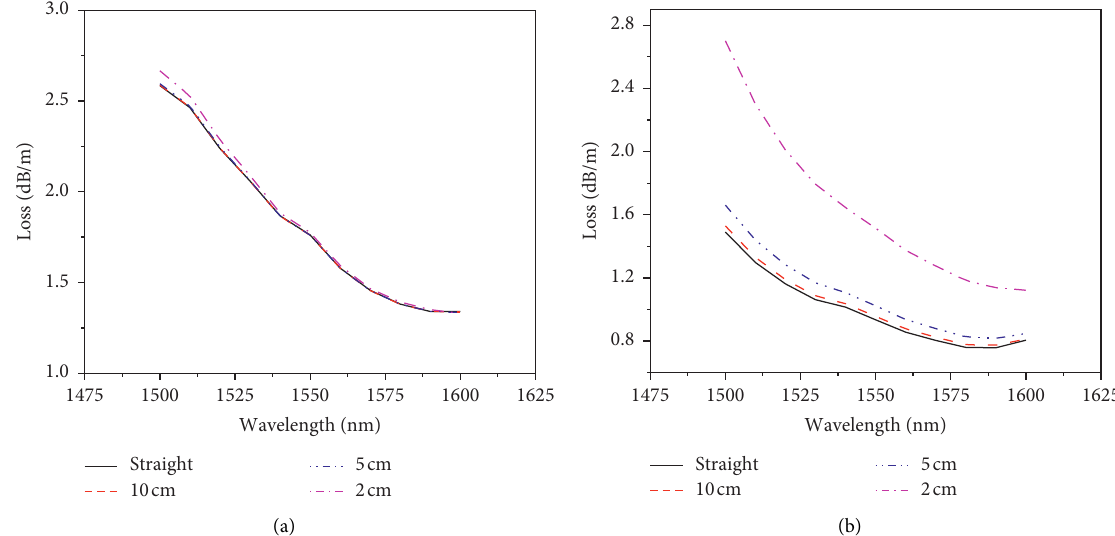
Figure 11: Fiber bends in x direction, the bending loss of (a) x polarization mode and (b) y polarization mode curve at different bending